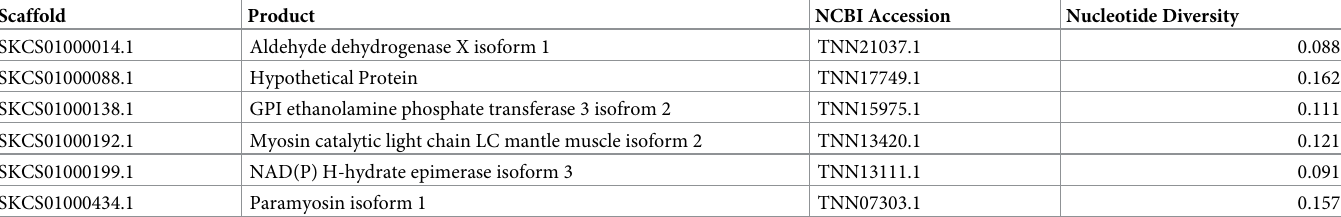
Table 3. Genes found within the top 10 windows (1kb) of nucleotide diversity. Scaffold number, gene product, accession numbers, and nucleotide diversity are reported.